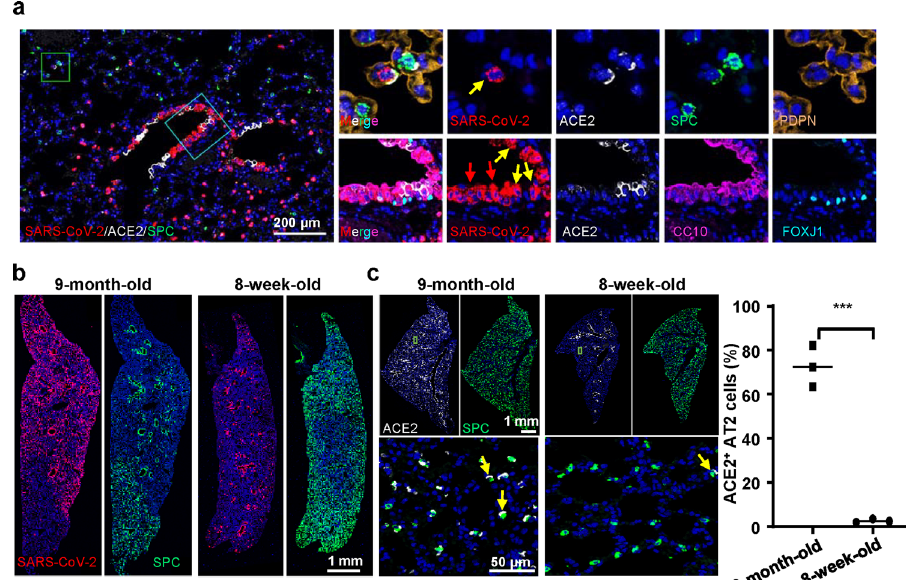
Fig. 2 Difference of MASCp36 cellular tropism in lungs from 9-month-old and 8-week-old mice. a Multiplex immuno fl uorescence staining for detection of SARS-CoV-2 targeted cells in lung sections of male mouse (9-month-old) at 1 dpi. SARS-CoV-2 N protein (red), ACE2 (white), SPC (green), PDPN (gold), CC10 (magenta), FOXJ1 (cyan). The framed areas are shown adjacently at a higher magni fi cation. The yellow arrows indicate ACE2 + club cells infected with SARS-CoV-2, and the red arrows indicate decreased ACE2 expression in infected cells ( n = 3 per group). b Multiplex immuno fl uorescence staining of lung sections for SARS-CoV-2 N protein (red) and SPC (green) detection in male mice at 1 dpi ( n = 3 per group). c Multiplex immuno fl uorescence staining for detection of ACE2 (white) and SPC (green) expression in lung tissues from the uninfected control mice (9-month-old and 8-week-old). The framed areas are shown below at a higher magni fi cation. The yellow arrows indicate ACE2 + cells. The percentage of ACE2 + cells in the SPC + AT2 compartment was statistically analyzed by two-tailed Student ’ s t test ( P = 0.0002) *** P < 0.01. Data are presented as mean ± SD ( n = 3 per